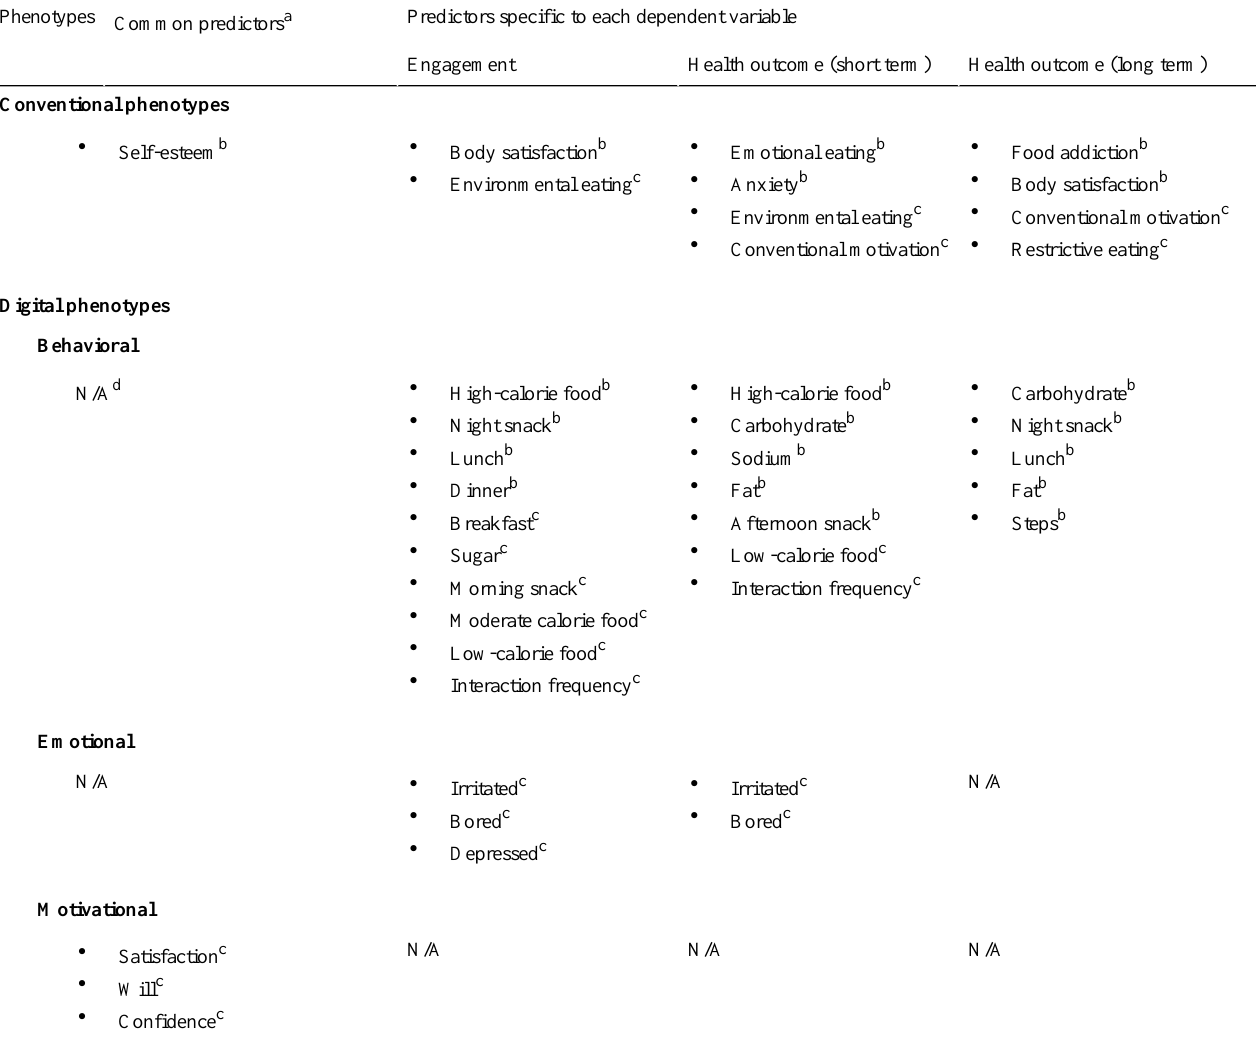
Table 2. Common and specific predictors of conventional and digital phenotypes for predicting engagement and health